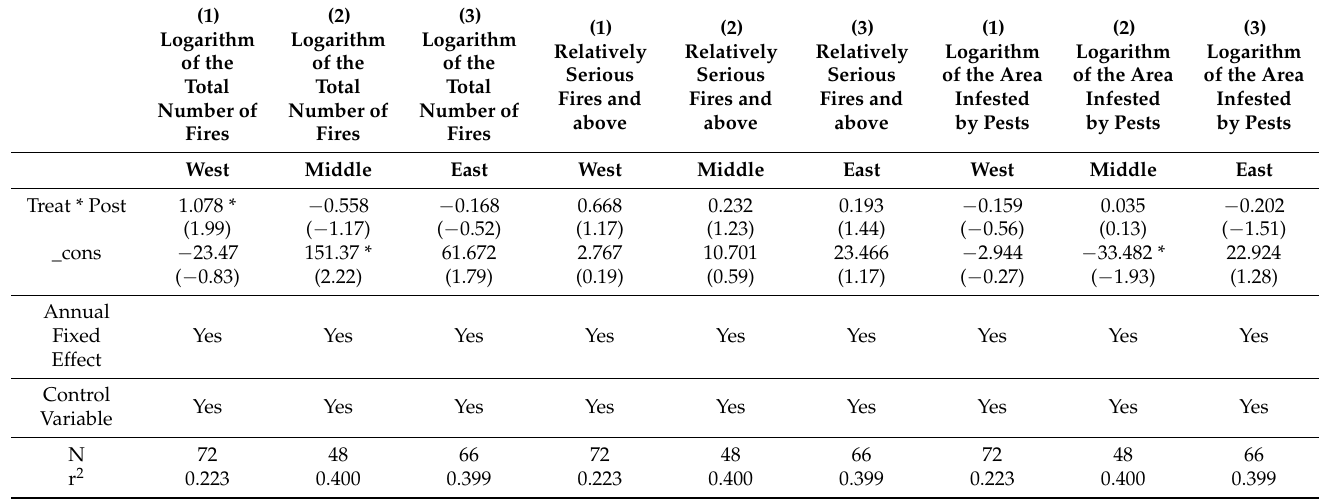
Table 11. Fixed effects regression model results: regional